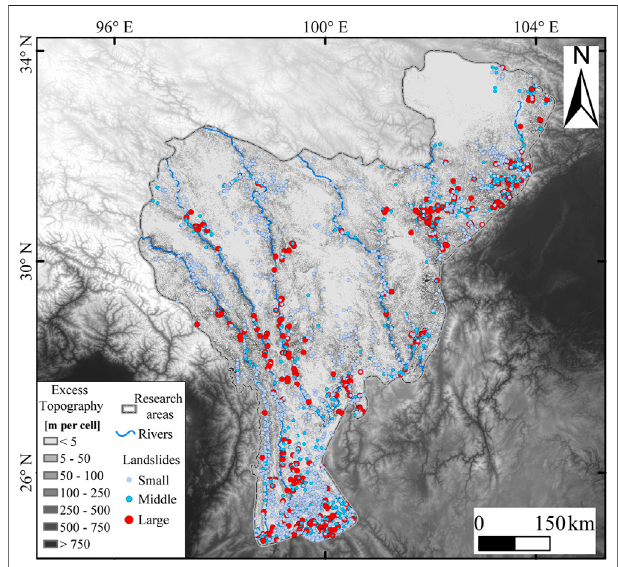
FIGURE 6 | Distribution of landslides in excess